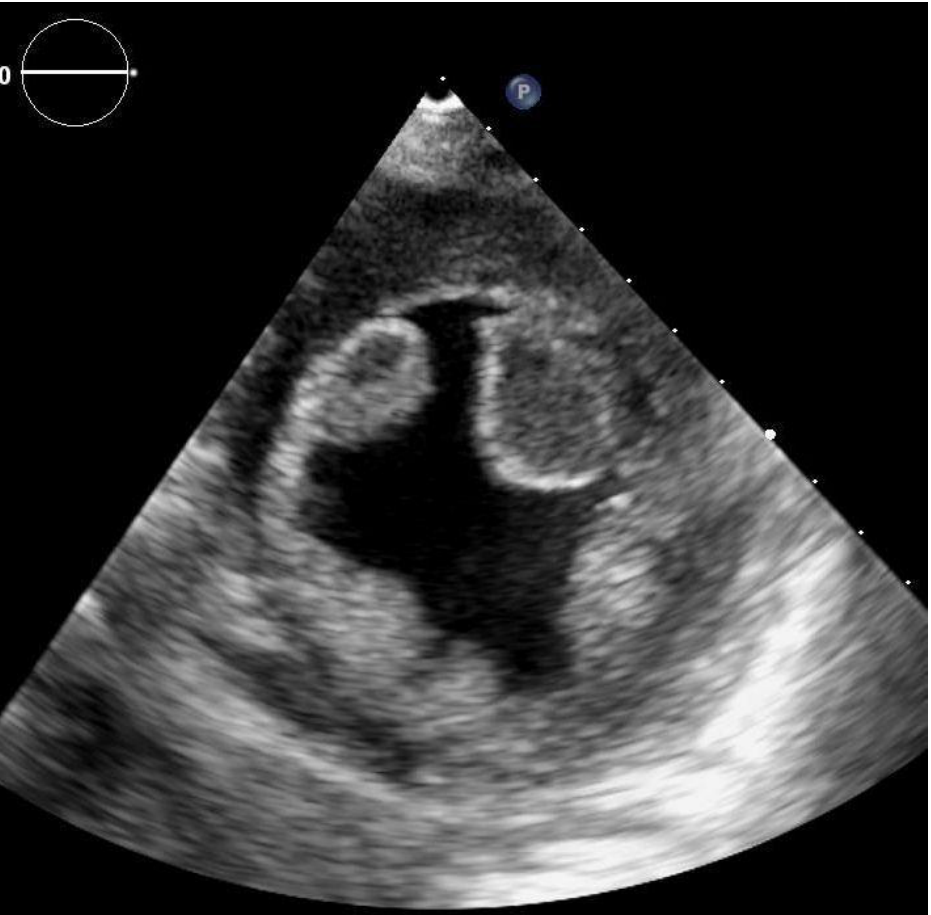
Figure 2. 2D transthoracic echocardiography, parasternal short axis view at the level of papillary muscles—visualization of apical-septal (AS) and -lateral (AL) thrombi in the anterior part of the left ventricle.